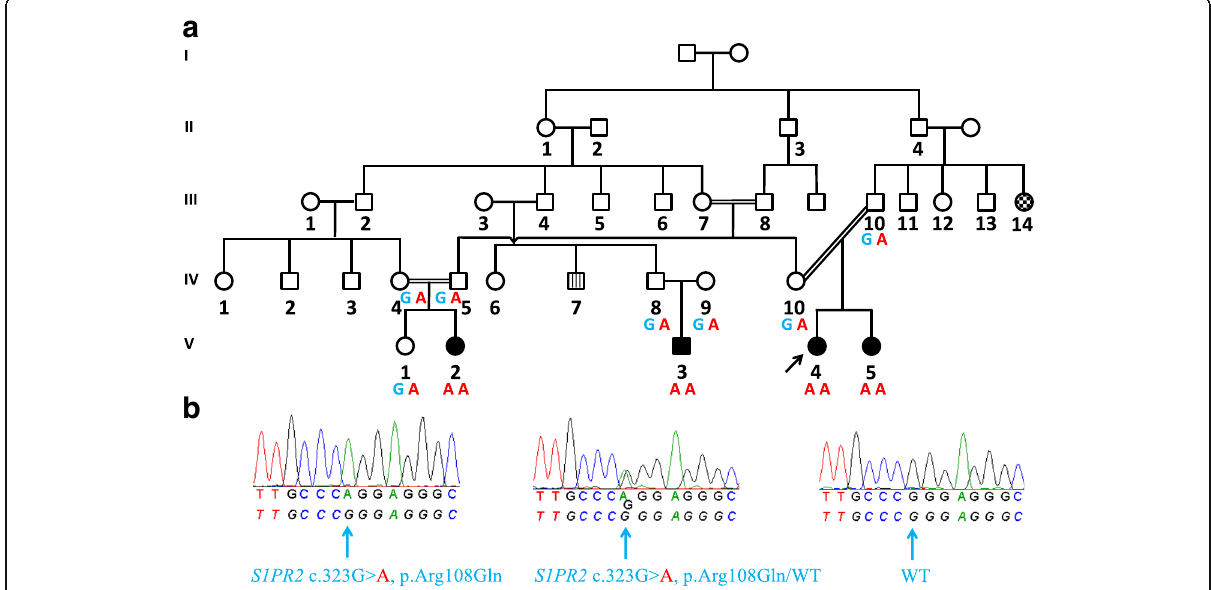
Fig. 1 Pedigree and segregation of the S1PR2 c.323G>A variant in family E30. a A five generation family with four affected individuals with HL and seven unaffected family members was subjected to segregation testing. The wild type allele is marked in blue, the variant in red. The segregation results are shown below each individual who was tested. Parental consanguinity is noted for V-2, as well as V-4 and V-5. Affected individuals with HL are colored in black and unaffected individuals are colorless. An individual with epilepsy is marked with a checkered pattern (III-14) and an individual with polydactyly is indicated with a striped pattern (IV-7). b Sanger sequence chromatograms of the S1PR2 c.323G>A pathogenic variant in homozygous (left) and heterozygous (center) orientations. An illustrative WT Sanger sequence chromatogram is also included (right). The reference sequence is shown at the bottom, whereas the individual nucleotide sequence is shown at the top. A blue arrow indicates the c.323